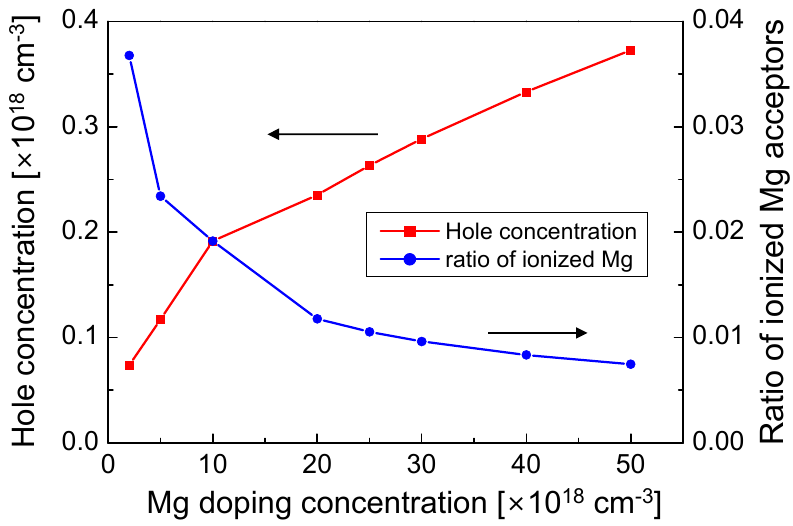
Figure 2. Hole concentration (right vertical axis) and the ratio of ionized Mg acceptor atoms (left vertical axis) for the simulated LD structure as a function of Mg doping concentration in the p-AlGaN cladding layer.